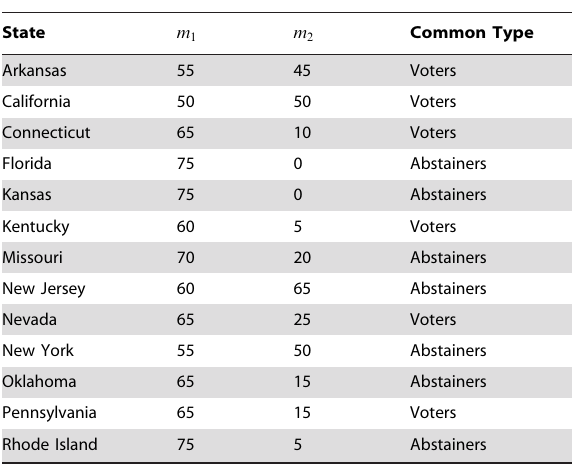
Table 2. Number of Draws. Table 3. Number of